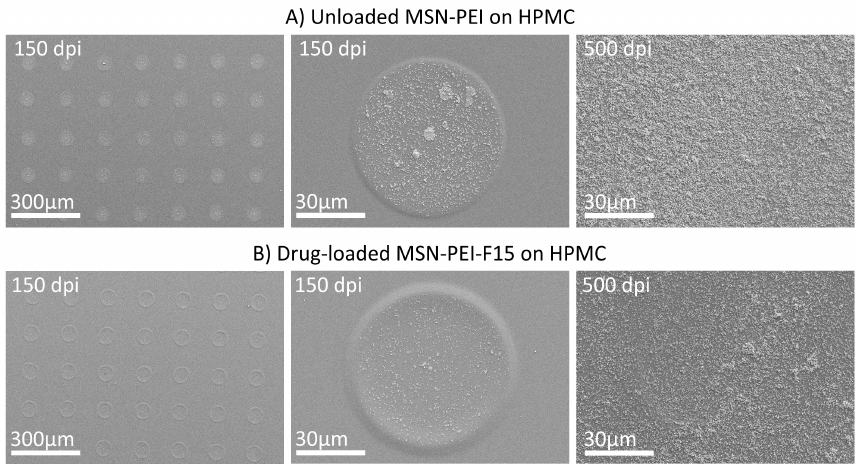
Figure 9. Ink deposits of ( A ) unloaded MSN–PEI and ( B ) drug-loaded MSN–PEI–F15 suspensions (5 mg/mL) with 150 dpi (one layer) and 500 dpi (five layers) with ×100 (300 µm) and ×1000 (30 µm) magnifications.